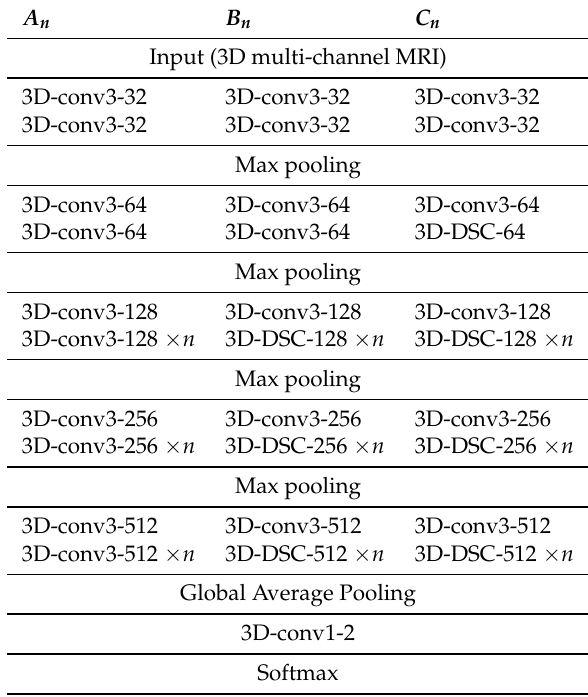
Table 2. Architecture overview (shown in columns). A n are the networks with normal 3D convolution; B n and C n are the networks with 3D-DSC; and n represents the number of the additional convolution layers. The 3D convolutional kernel parameters are expressed as “3D-conv (cid:104) kernel size (cid:105) /3D-DSC- (cid:104) number of output channel (cid:105) ”. The leaky ReLU activation layer and batch normalization layer are not shown here for brevity. A n B n C n